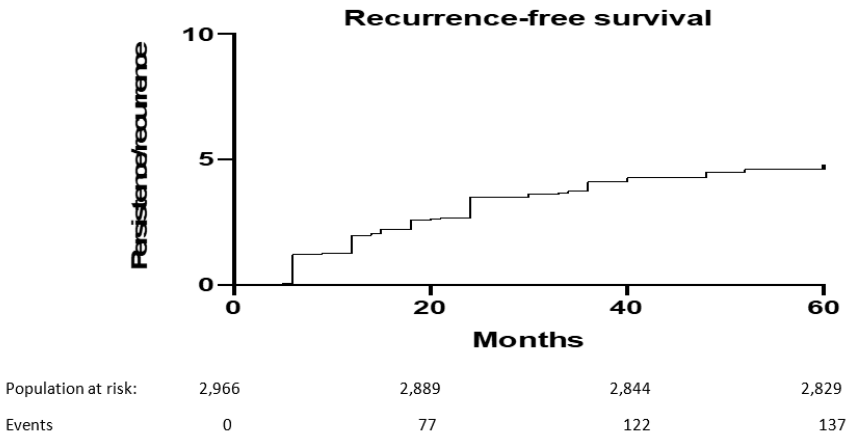
Figure 1. Five-year recurrence-free survival after primary conization.